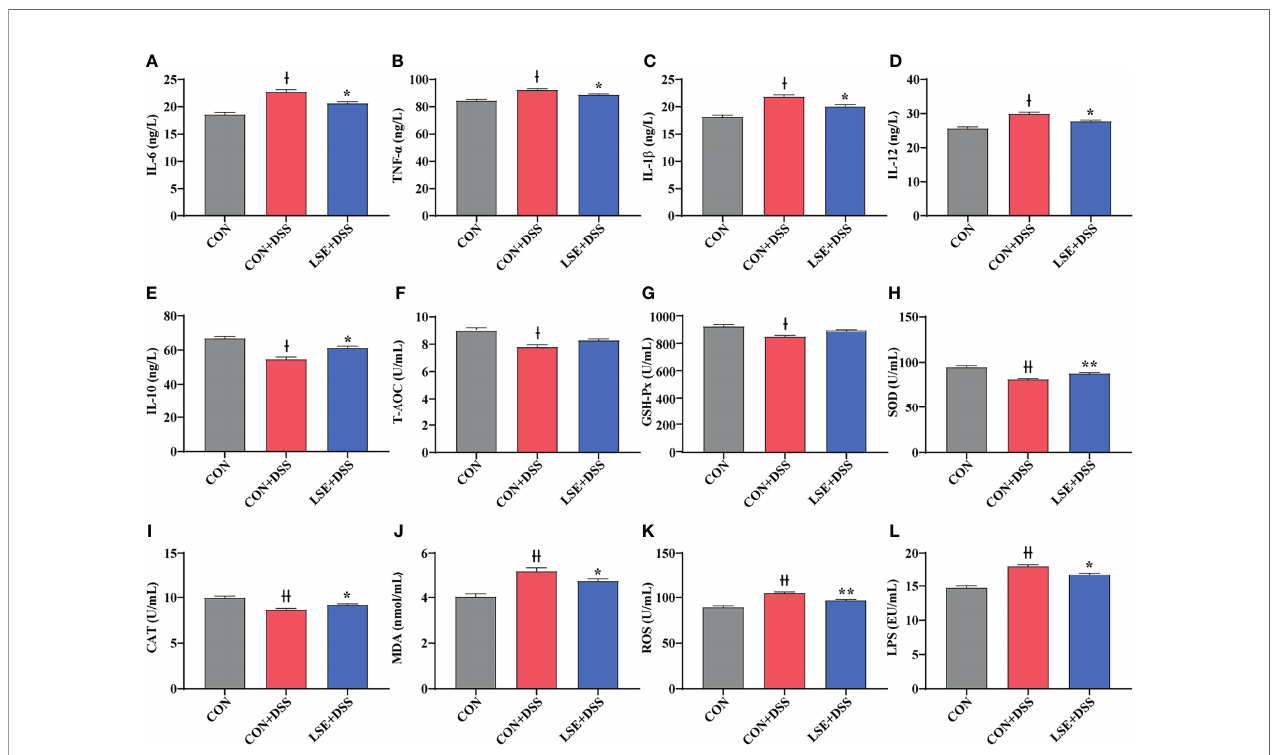
FIGURE 3 | Effects of LSE supplementation on serum in fl ammation cytokine and antioxidant parameters in DSS-induced colitis mice. (A) IL-6. (B) TNF- a . (C) IL-1 b . (D) IL-12. (E) IL-10. (F) T-AOC. (G) GSH-Px. (H) SOD. (I) CAT. (J) MDA. (K) ROS. (L) LPS. Data are presented as mean ± SEM, n = 10. * P < 0.05 and ** P < 0.01 vs. the CON+DSS group. † P < 0.05 and †† P < 0.01 vs. the CON